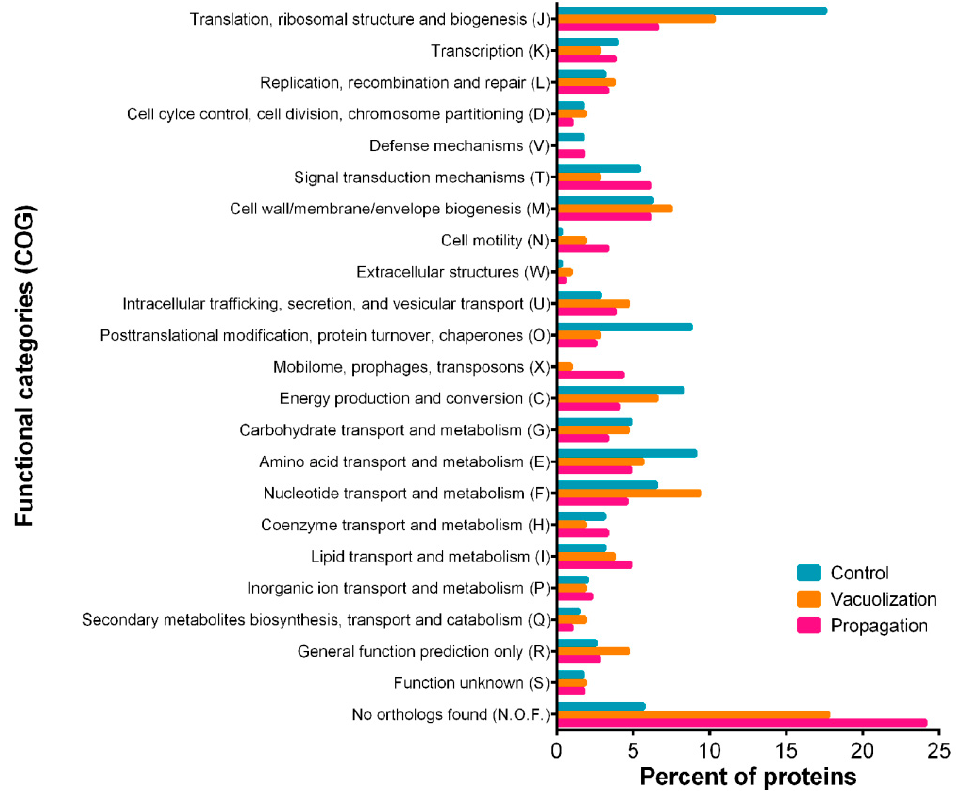
Figure 3. Functional categories of P. salmonis proteins Percent of proteins in each COG (Cluster of Orthologous Groups) related to the total bacterial proteins identified by quantitative proteomic for the control condition (exponentially growing bacteria in nutrient broth, blue), vacuolization (bacteria inside SHK-1 cells in vacuolization stage of infection, orange), and propagation (bacteria inside SHK-1 cells in propagation stage of infection, pink).